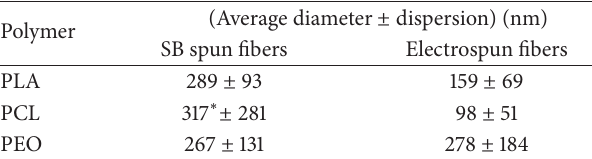
Table 3: Average diameter of spun